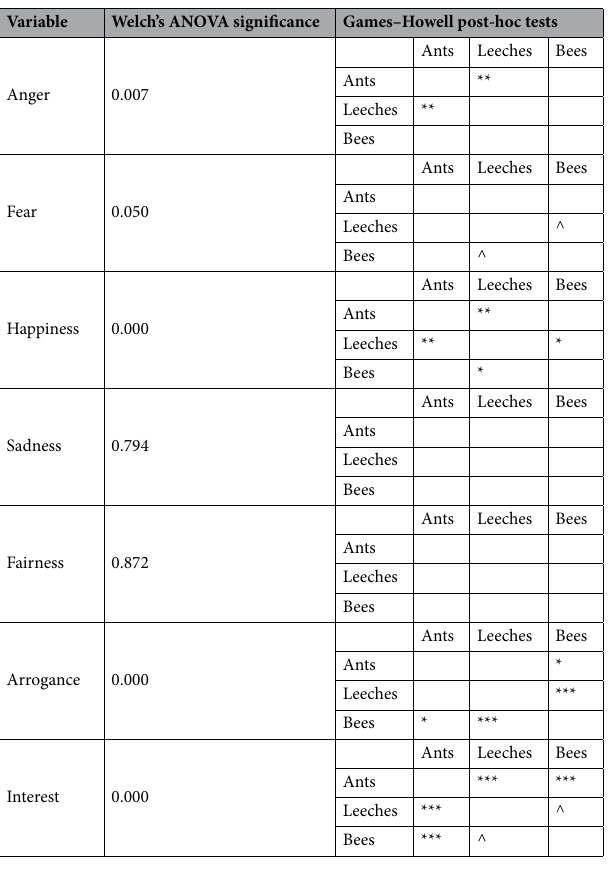
Table 3. Welch’s ANOVA—Service Company dataset. ^p < 0.1; *p < 0.05; **p < 0.01; ***p <